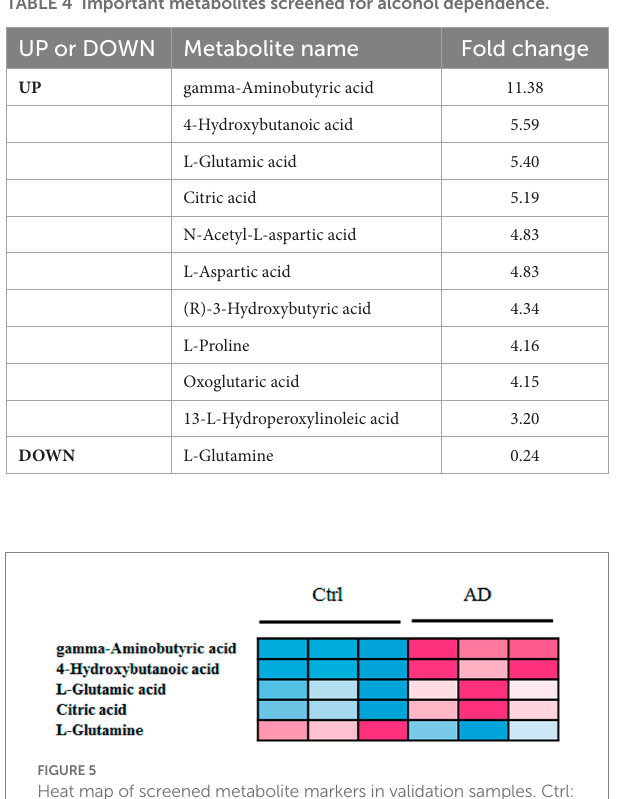
TABLE 4 Important metabolites screened for alcohol